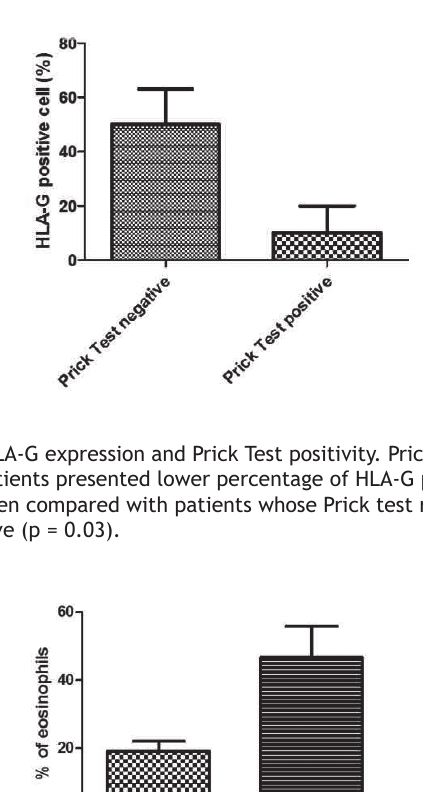
Figure 1 HLA-G protein detection SNP biopsies. Photomicro- graph showing different categories of immunolabeling intensi- ty. A , Strong staining by epithelial cells; B , Moderately and C , weak staining; D , Expression of HLA-G by immune-inflamma- tory cells; E , Positive SNP patient sample to HLA-G expression and F , the isotype control (irrelevant antibody); G , Negative sample to HLA-G expression. Original magnification 10× (B,C and F), 20× (A) and 40× (D and G).